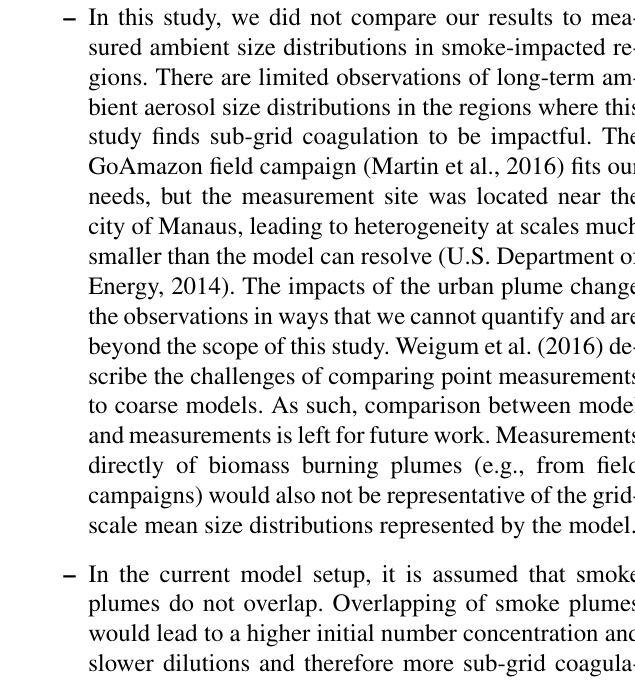
Figure 6. Global-mean all-sky direct radiative effect due to biomass burning (DRE) and cloud-albedo aerosol indirect effect due to biomass burning (AIE) for all sensitivity simulations with and with- out sub-grid coagulation. The green bars represent the DRE aver- aged over all size-distribution, mixing-state sensitivity, and coagu- lation time sensitivity simulations. The blue bars represent the AIE averaged over all size-distribution and coagulation time sensitivity simulations. The left-hand bars represent simulations using GFED fire emissions, and the right-hand bars represent simulations using FINNv1 fire emissions. The diamond, square, and triangle symbol shapes represent the globally averaged value for the different emit- ted size distributions, as indicated in the legend, with a coagulation time of 24h. The star symbol shape represents the globally averaged value for the SubCoag_12h case, which has an emitted median di- ameter of 100nm and an emitted modal width of 2, like the square symbol case but with the time spent undergoing sub-grid coagula- tion reduced from 24 to 12h, run only with GFED fire emissions. The filled symbols for DRE represent cases with an external mix- ture, and the open symbols represent cases with a core-shell mix-